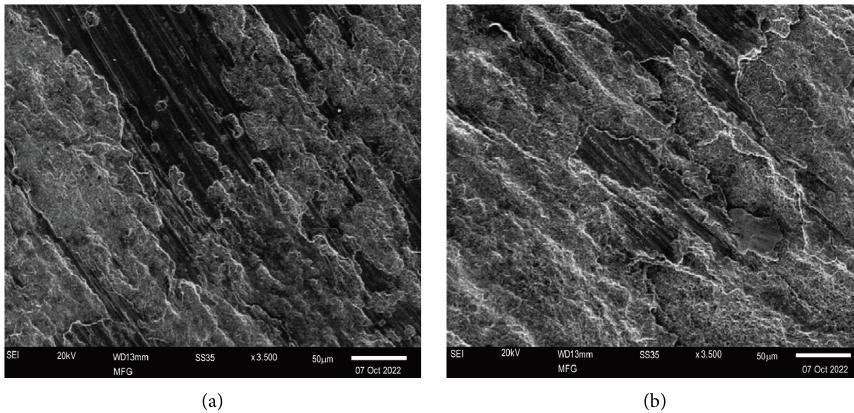
Figure 7: SEM morphologies of worn surfaces of (a) 8% AA5052/145-B